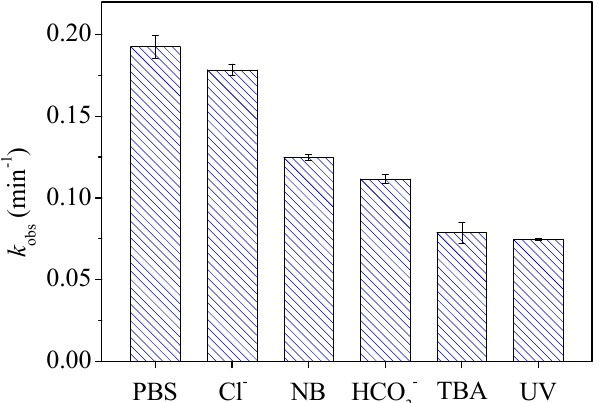
Figure 4. Observed degradation rate constant ( k obs ) of CTZ (10 µ M) in UV/chlorine system ((Free chlorine) 0 = 100 µ M) under different conditions (PBS, pH = 7.0; (Cl − ) = 50 mM; (NB (nitrobenzene)) = 2 µ M; (HCO 3 − ) = 100 mM; (TBA ( tert -butanol)) = 100 mM) and in UV system as a control (the error bars represent the 95% confidence interval ( n =